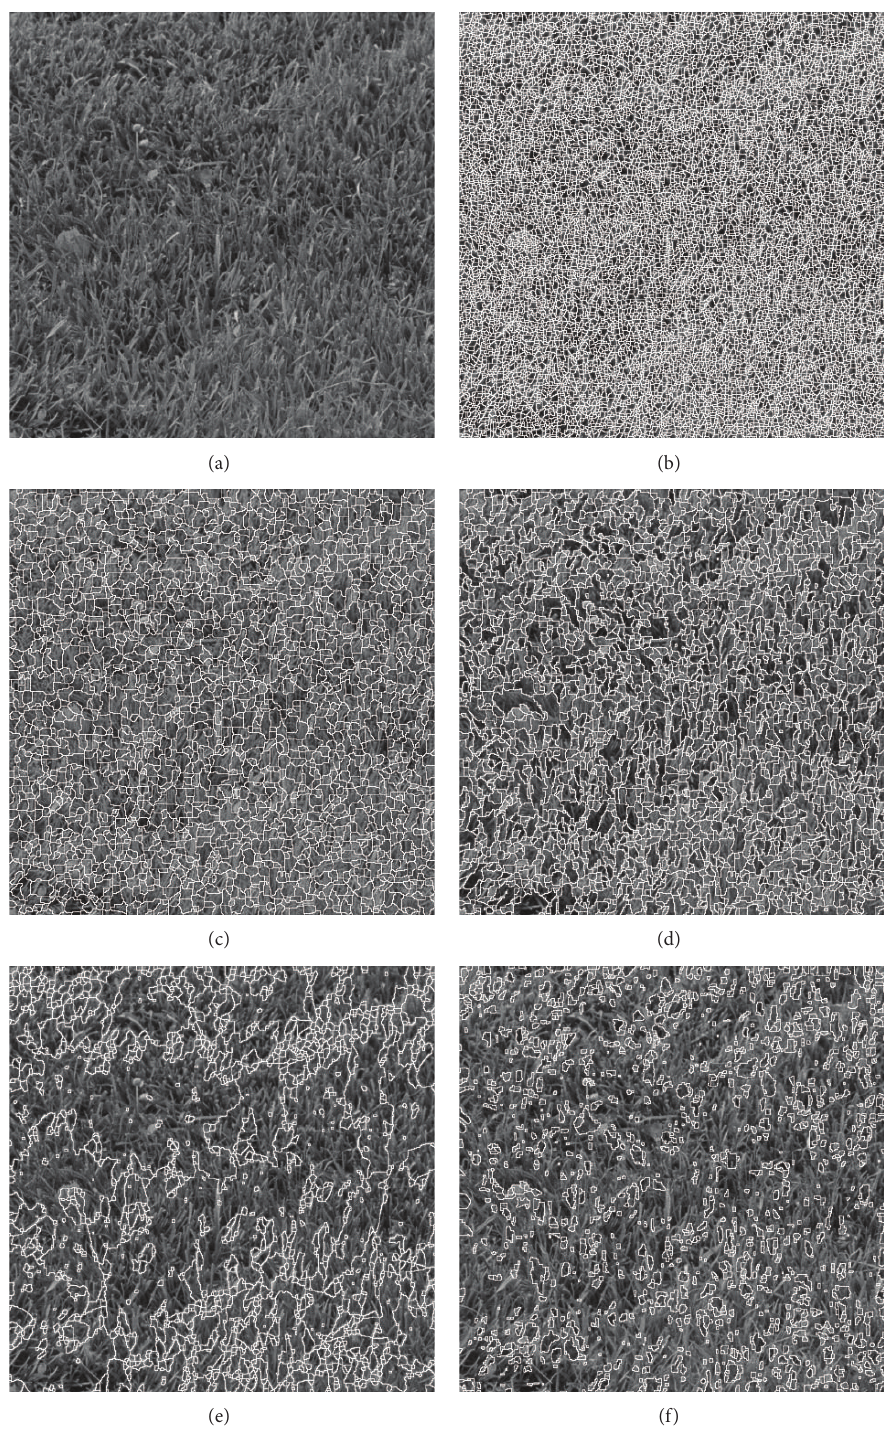
Figure 4: From left to right and from top to bottom: original image, result of traditional watershed algorithm, result of final multiscale gradient algorithm, result of [4] algorithm, result of [15] algorithm, and result of the new